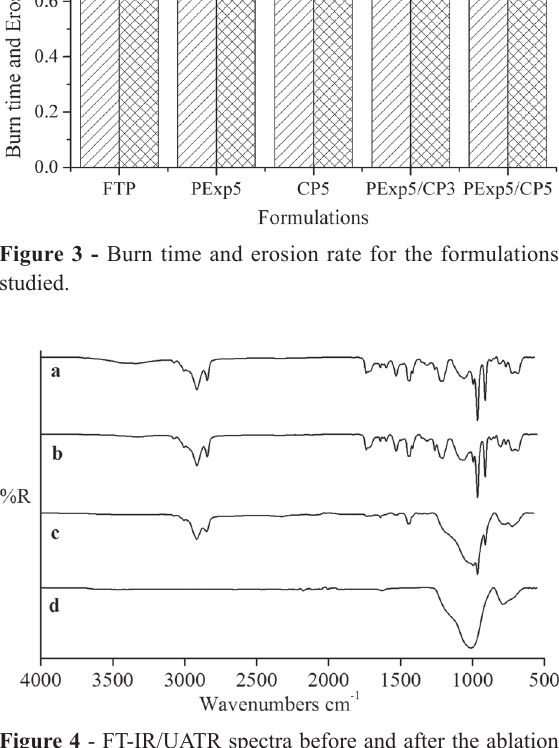
Figure 4 - FT-IR/UATR spectra before and after the ablation test: a ) cured HTPB; b ) PExp5 before ablation; c ) PExp5 after ablation; and d ) PExp